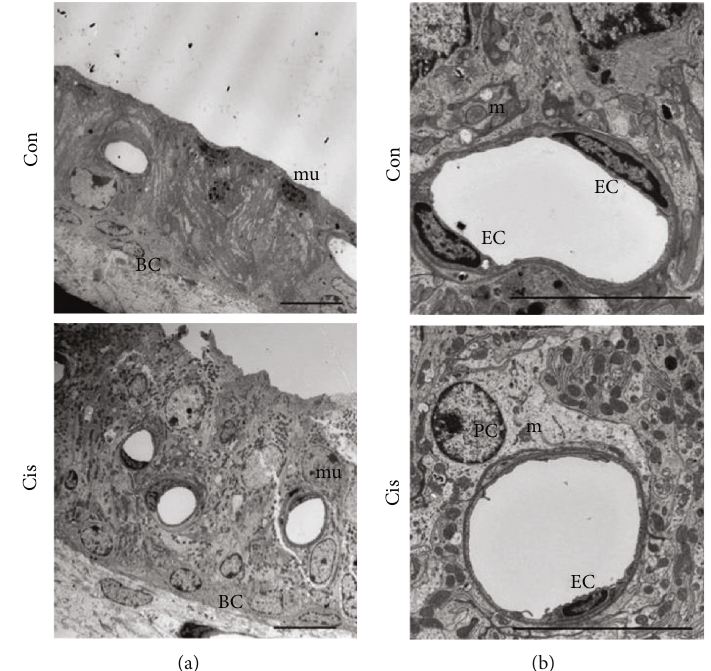
Figure 2: Cisplatin changes the ultrastructure of SV cells. (a, b) The ultrastructure of SV was observed by TEM. Both the size and the shape of cell nuclei appeared normal, and mitochondria were prevalent and occurred in a highly organized manner in the control mice. A thicker SV and more blood vessels were observed in the cisplatin-treated mice; the numbers of mitochondria and endothelial cells were reduced; and most of the cells were in an abnormal shapes with large and round nuclei, a swollen endoplasmic reticulum, and a thinner vascular wall in cisplatin-treated mice. Con: 0.9% physiological saline; Cis: cisplatin; EC: endothelial cell; m: mitochondrion; PC: pericyte; mu: marginal cell nucleus. Scale bars, 10 μ